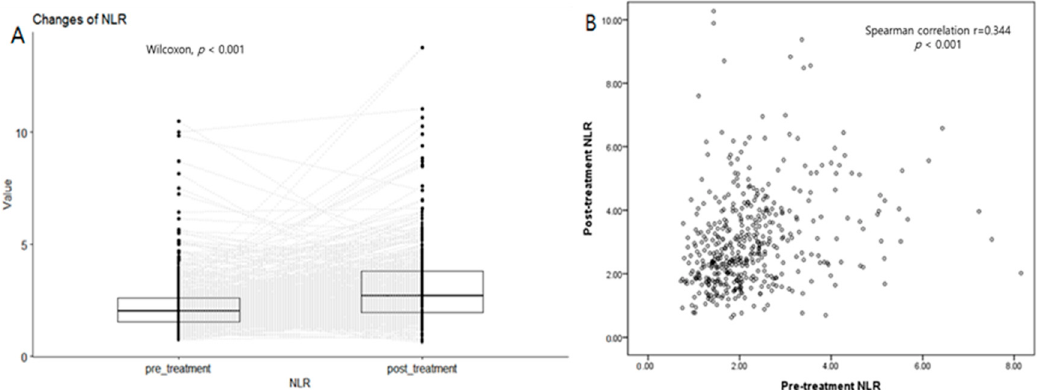
Figure 2. ( A ) Paired box plots of pre- and post-treatment NLR. Each pair of pre-and post-treatment NLR is connected by a dotted line. Post-treatment NLR is significantly higher than pre-treatment NLR. (Wilcoxon singed rank test, p < 0.001). ( B ) Scatter plot showed a modest but significant correlation between pre-and post-treatment NLR (Spearman correlation coefficient r = 0.344, p < 0.001). Based on OS, the optimal cutoffs for pre-treatment and post-treatment NLRs were 2.37 and 3.86 (AUC = 62.4 and 53.7), respectively. Meanwhile, the optimal cutoff values